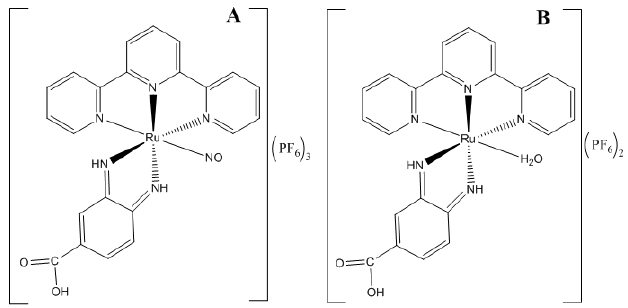
Figure 1. Chemical structure of complexes: ( A ) Ru ‐ NO (MW = 949.9 g ∙ mol − 1 ) and ( B ) Ru ‐ aqueous (MW = 792.4 g ∙ mol − 1 ).